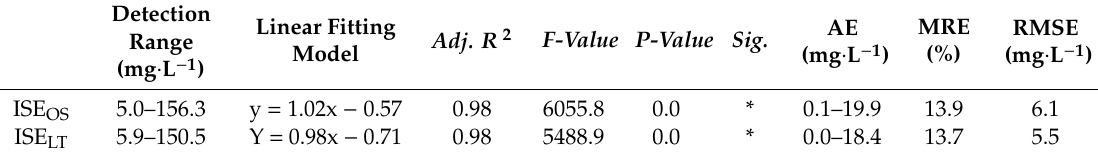
Table 2. Statistical analysis of the linear regression fitting results.